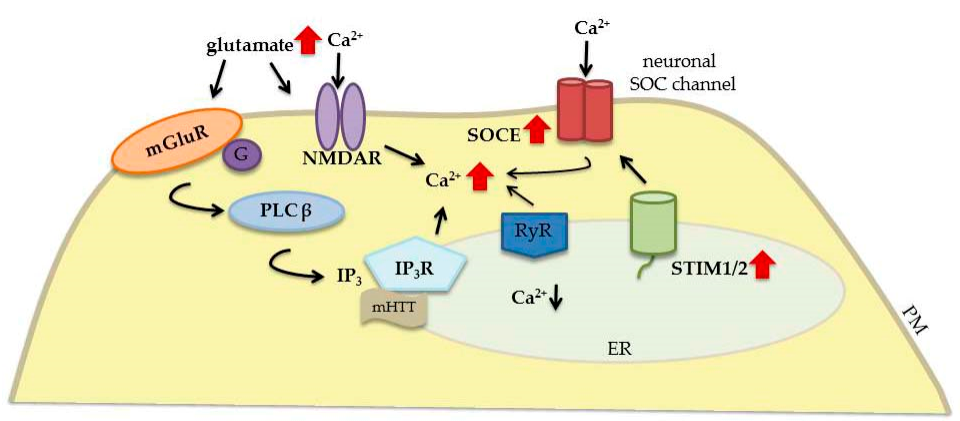
Figure 6. Contribution of neuronal STIM proteins and glutamate receptors to Ca 2 + signaling dysregulation in HD. The elevation of glutamate release leads to the excessive stimulation of glutamate receptors (e.g., NMDARs and mGluRs). The overactivation of NMDARs results in excessive Ca 2 + influx. In turn, mGluRs couple to G α -protein, which activates PLC β and induces the formation of IP 3 , which interacts with IP 3 Rs and causes the release of Ca 2 + from ER stores. mHTT increases the sensitivity of IP 3 R1 to IP 3 , which additionally enhances ER Ca 2 + release, resulting in a decrease in ER Ca 2 + levels, which in turn activates STIM, promotes SOCE, and contributes to Ca 2 + overload. Solid black arrows represent the interaction mechanisms; red solid arrows symbolize increased expression/concentration.